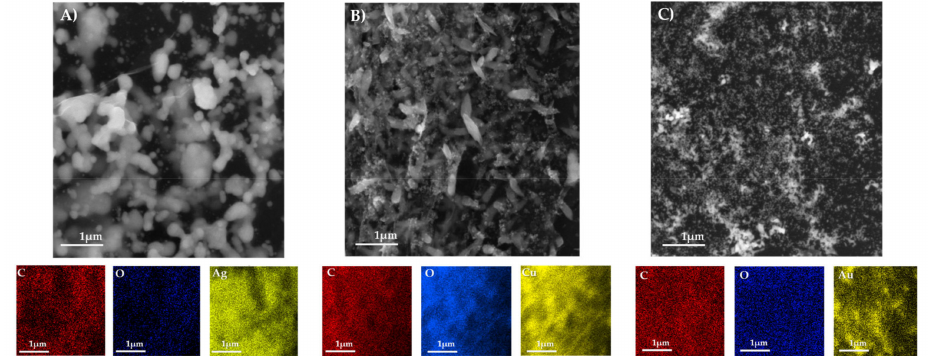
Figure 3. SEM images of nanocomposites of rGO decorated with the di ff erent metal nanoparticles. ( A )silvernanoparticles(AgNPs), ( B )coppernanoparticles(CuNPs), and( C )goldnanoparticles(AuNPs).